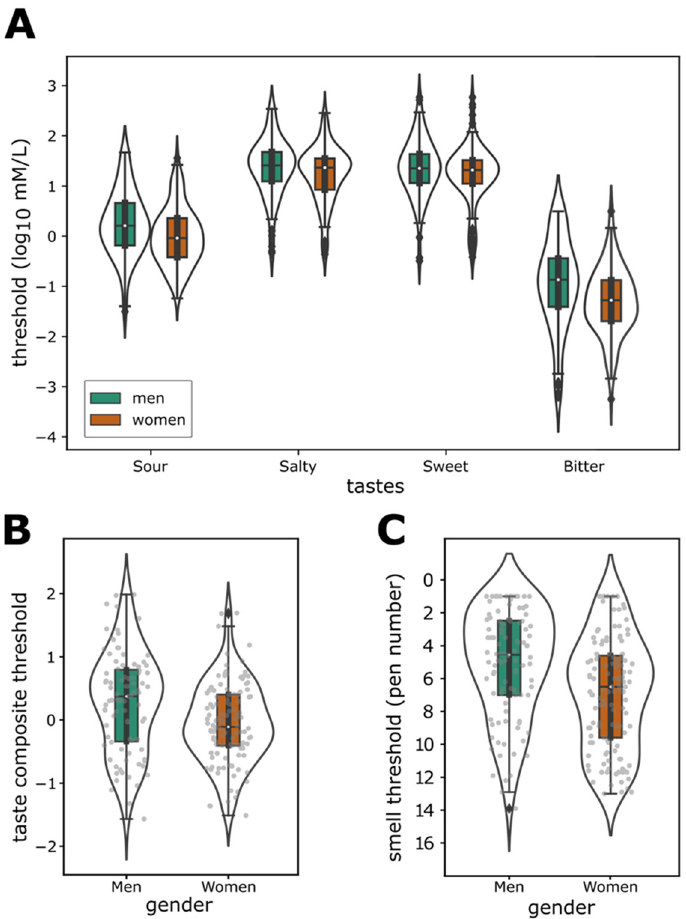
Figure 3. ( A ) Taste threshold estimates for salty, sour, sweet, and bitter. ( B ) Taste composite score (averaged z-transformed of the four tastes) for women and men. ( C ) Smell threshold estimates for PEA (rose-like smell) for women and men. Higher pen numbers indicate lower thresholds. Bars represent Tukey’s boxplot with violin plots superimposed on, whiskers show the upper and lower boundary of 1.5 inter-quartile range, dots are individual data points.